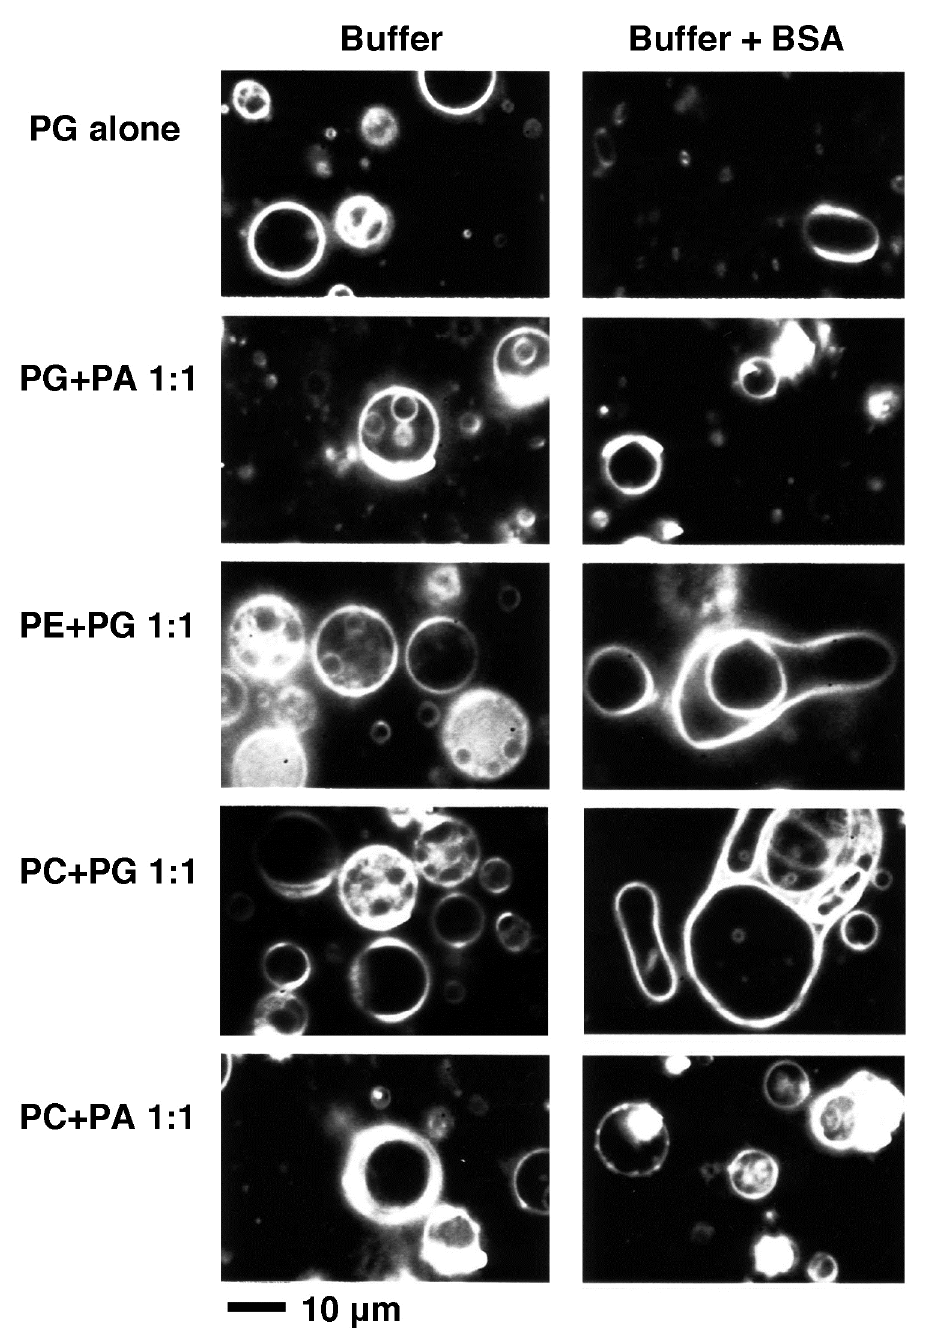
Figure 6. Dark-field images of liposomes prepared in the presence (right column) or absence (left column) of BSA. The lipid composition is indicated on the left of each row. HEPES-buffer with or without 2.0 mg/mL (30 μ M) BSA was used for swelling the lipid films to prepare liposomes. All phospholipids used here were obtained from native sources. Bar indicates 10 μ m. Observations were carried out at 25